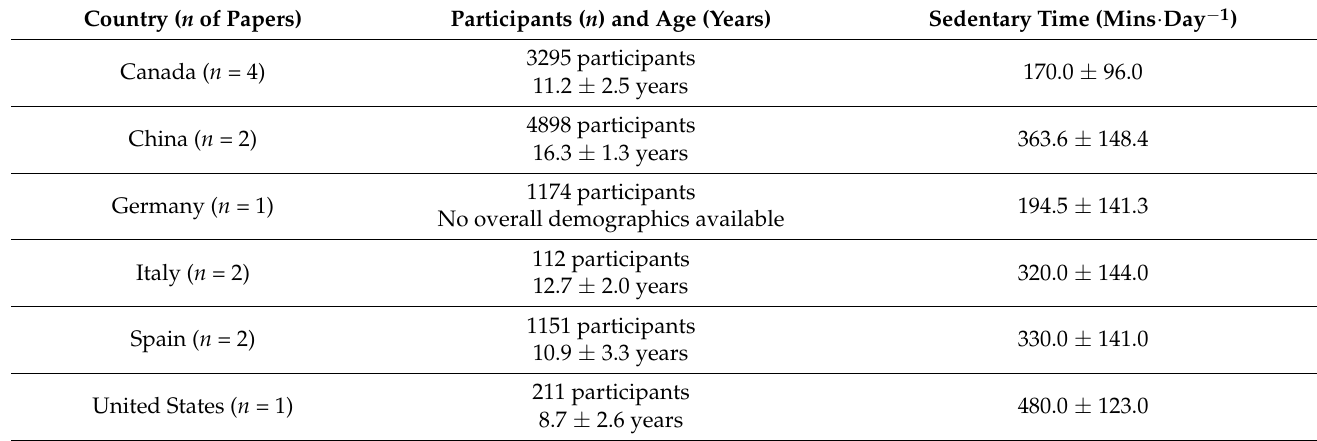
Table 3. Sedentary time of children during the COVID-19 pandemic by